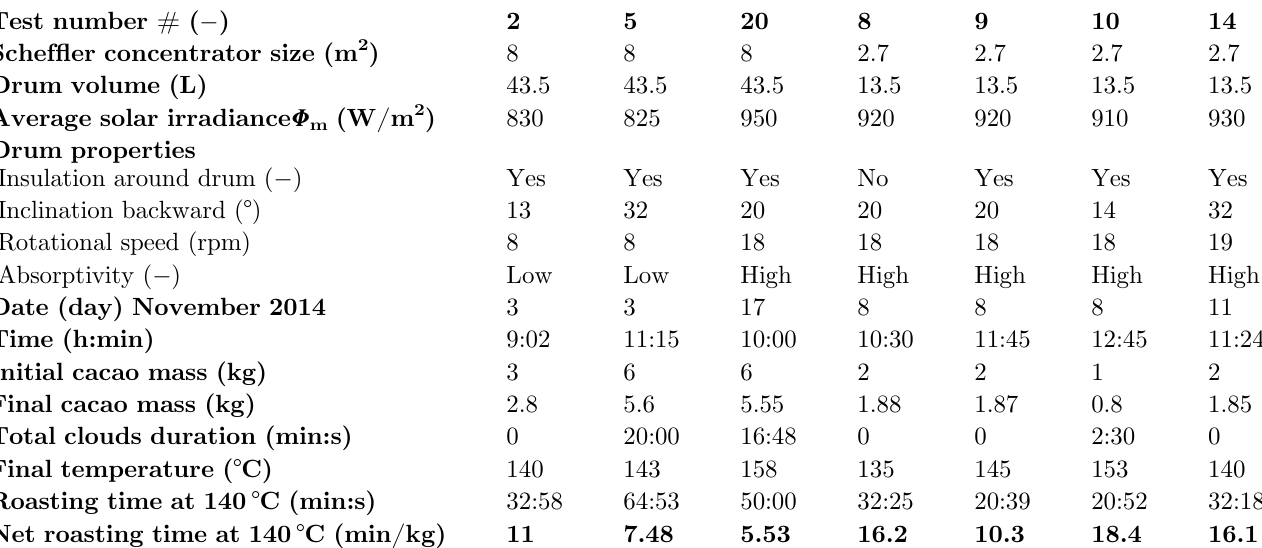
Table 1. Selection of seven roasting experiments: summary of main parameters and results. Test number # ( (cid:1)